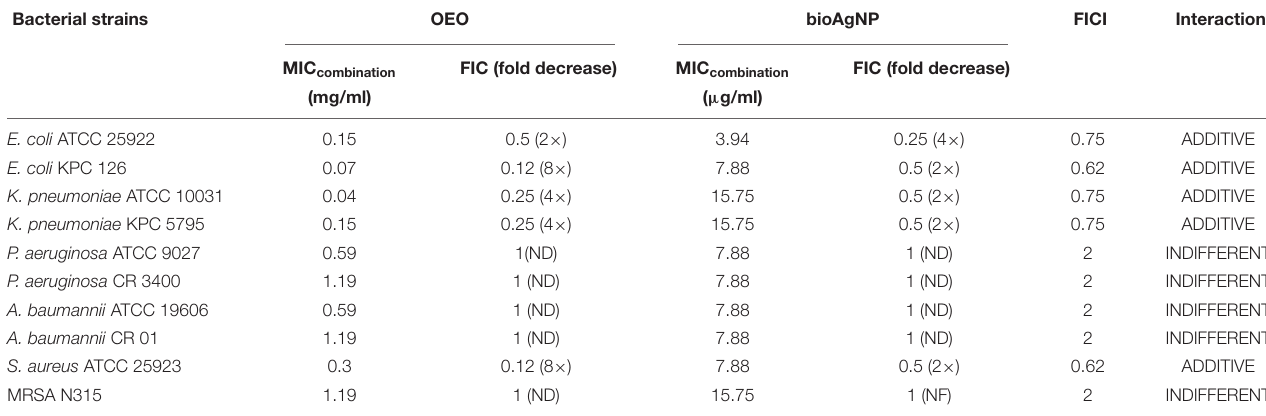
TABLE 2 | Effect of oregano essential oil (OEO) combined with biological silver nanoparticles (bioAgNP) against five bacterial species, including reference and multidrug-resistant strains. Bacterial strains